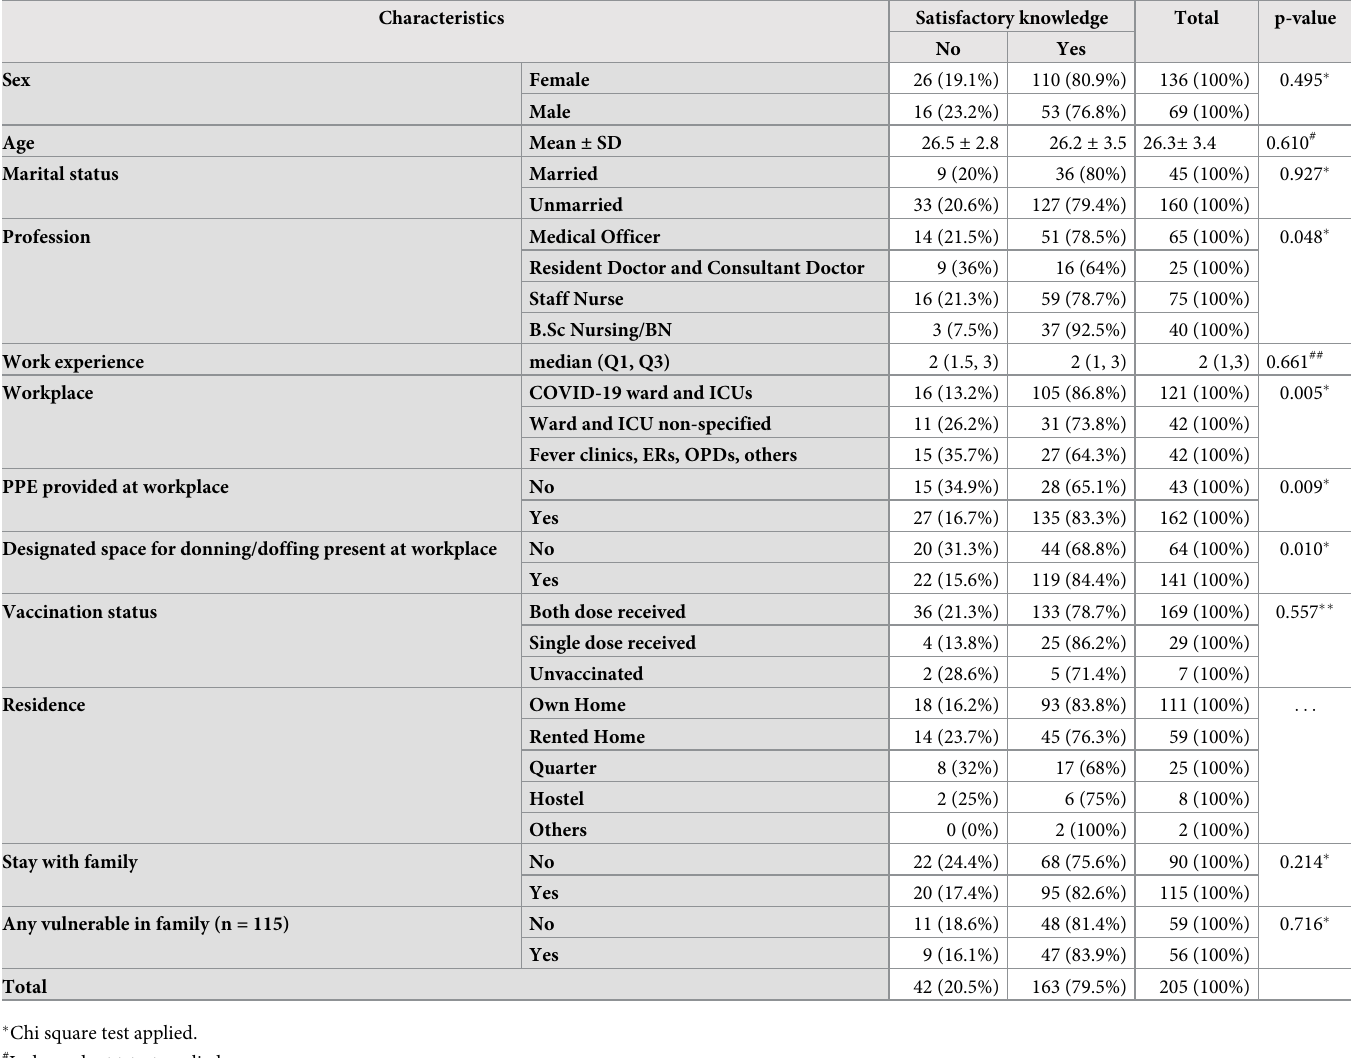
Table 4. Crosstabulation of factors with satisfactory knowledge scores (n =